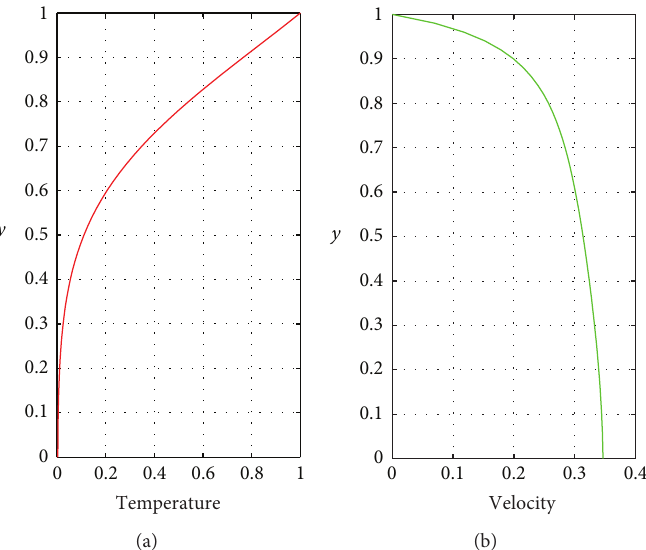
Figure 2: Velocity and temperature profiles at 𝑡 = 0.5